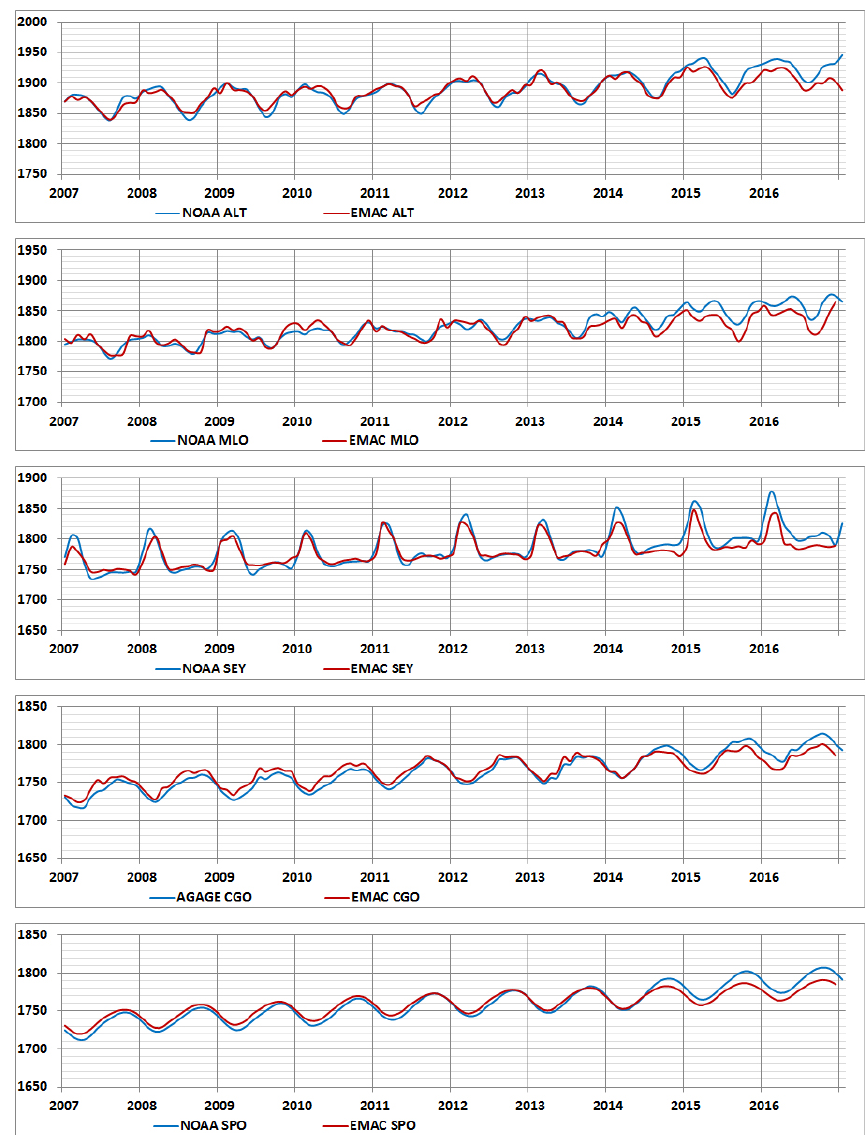
Figure 12. CH 4 development at NOAA and AGAGE stations (blue) vs. EMAC simulations (red) for the period 2007–2016; units of the mixing ratios are in nmolmol − 1 . The trend emissions are optimized for the linear rising period